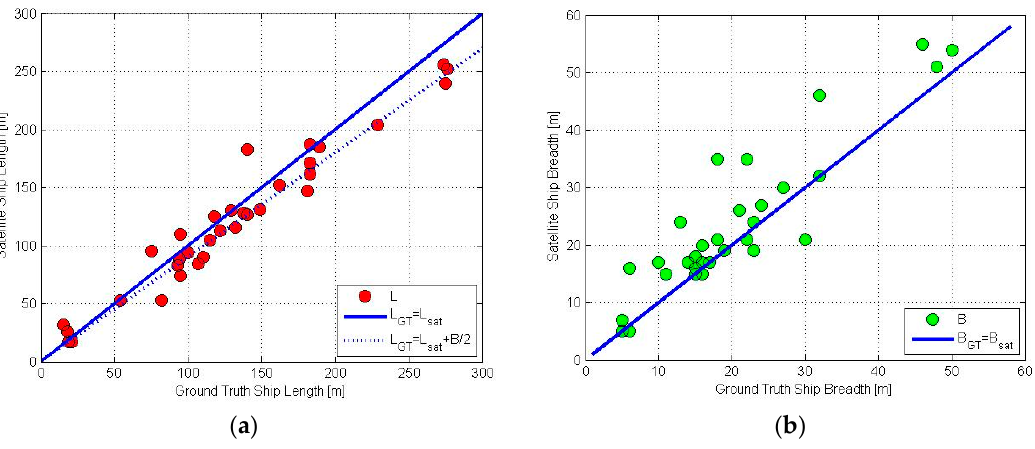
Figure 4. ( a ) Ship lengths and ( b ) breadths. The ground truth lengths and breadths are from AIS ship records. The satellite lengths and breadths are the calculated values as used in the model given in Table 1. Blue lines indicate agreement whereas dashed line includes bow corrections as described in text.